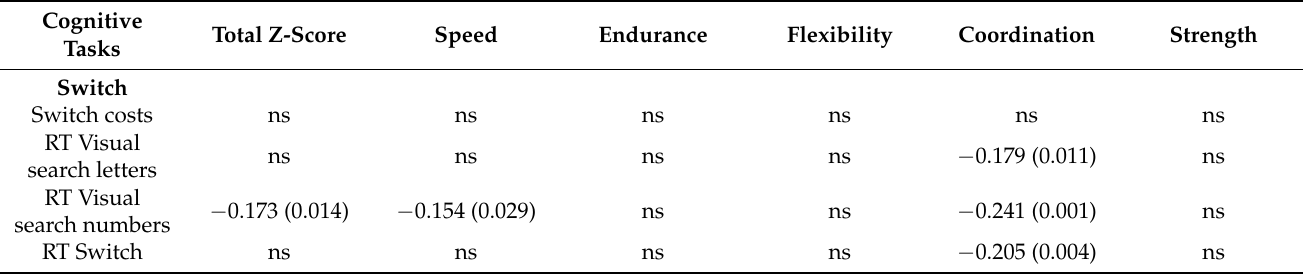
Table 3. Results of relationship between the fitness total Z-score, subtests according to endurance, strength, speed, coordination and flexibility, and the cognitive